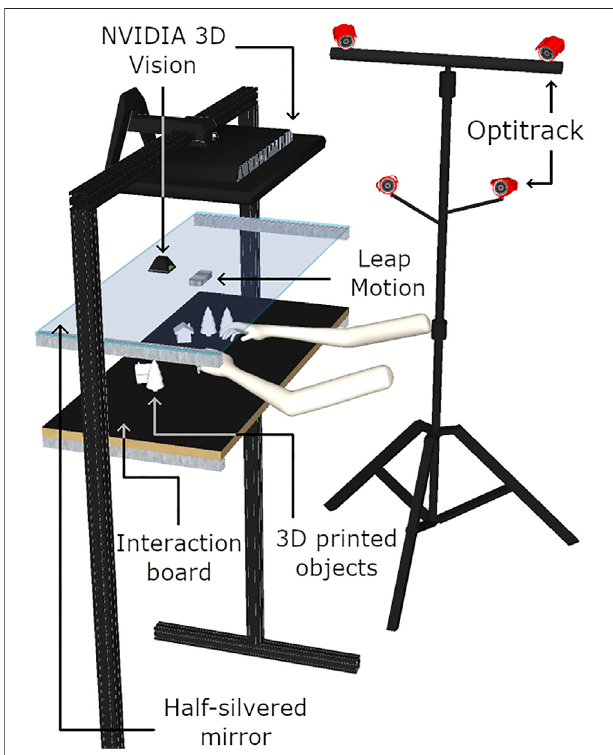
FIGURE 3 | The experimental setup in front of which the participants stood. Re fl ective markers were attached to the shutter glasses worn by the participants for head